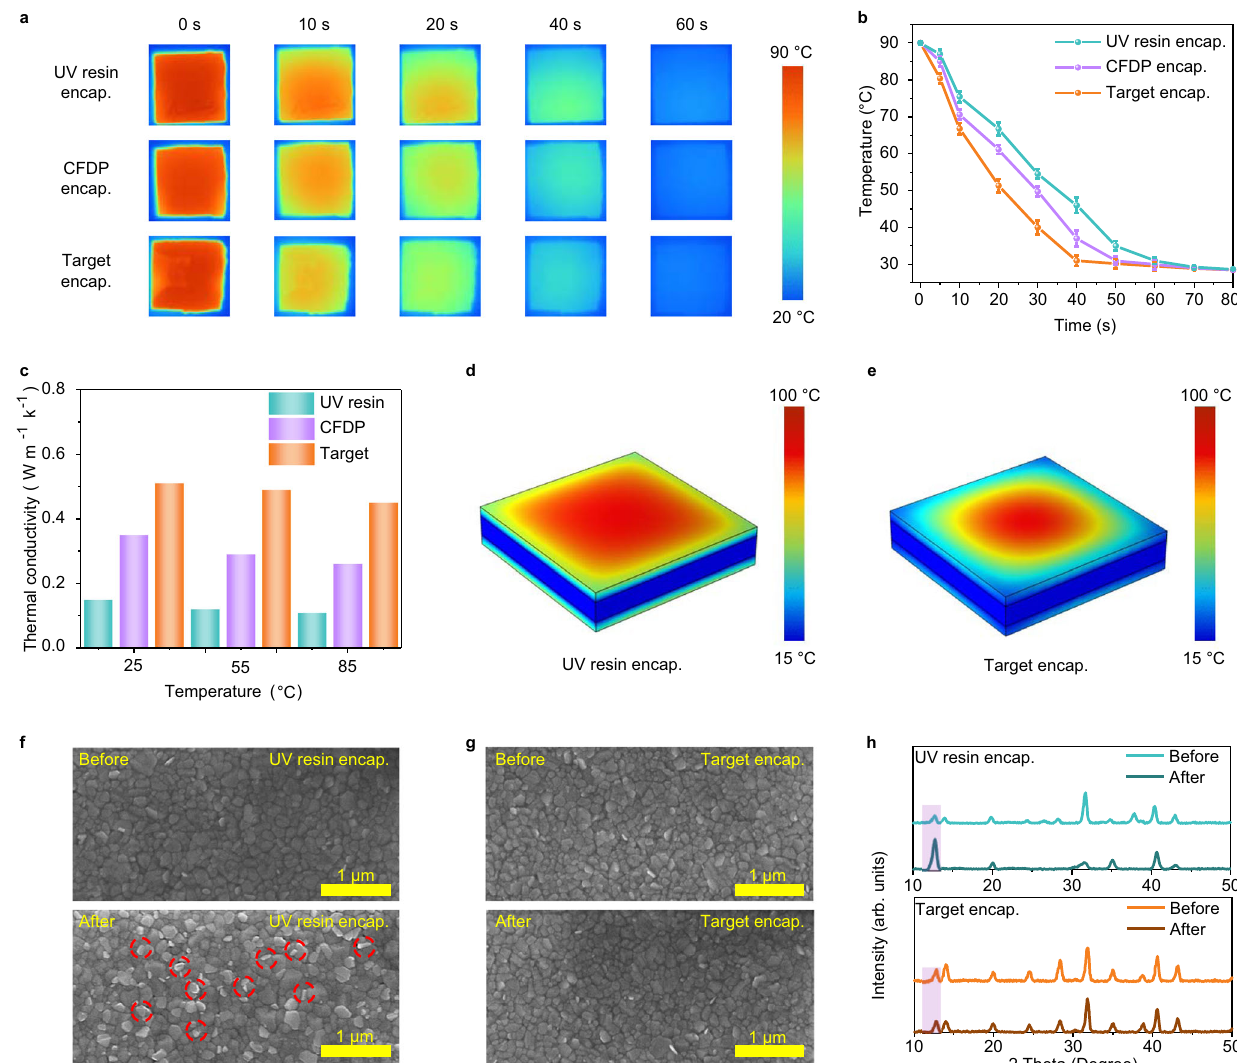
Fig. 2 | Heat dissipation performance characterization. a IR thermal images of encapsulated perovskite fi lms during a cooling test. b The surface temperature change of encapsulated perovskite fi lms versus time. The error bars represent the standard deviation for three samples. c Thermal conductivities of polymer sealant under different temperatures. d , e The heat transfer model with d UV resin encapsulation and e target encapsulation in COMSOL Multiphysics. f , g Top-view